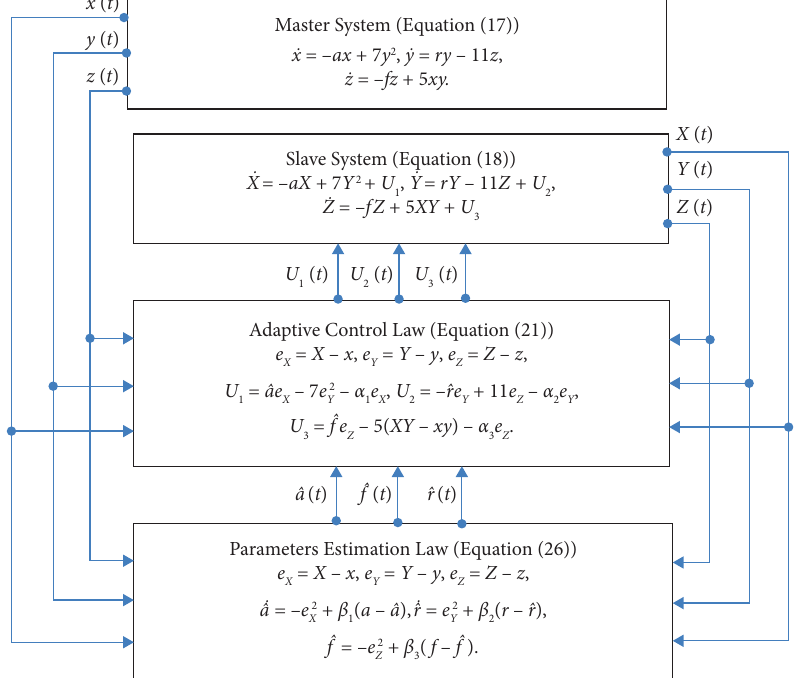
Figure 11: Block diagram of the master-slave synchronized chaotic